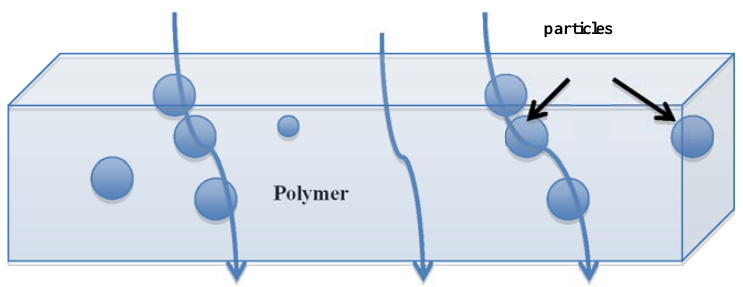
Figure 1. Gas permeation through mixed-matrix membranes.